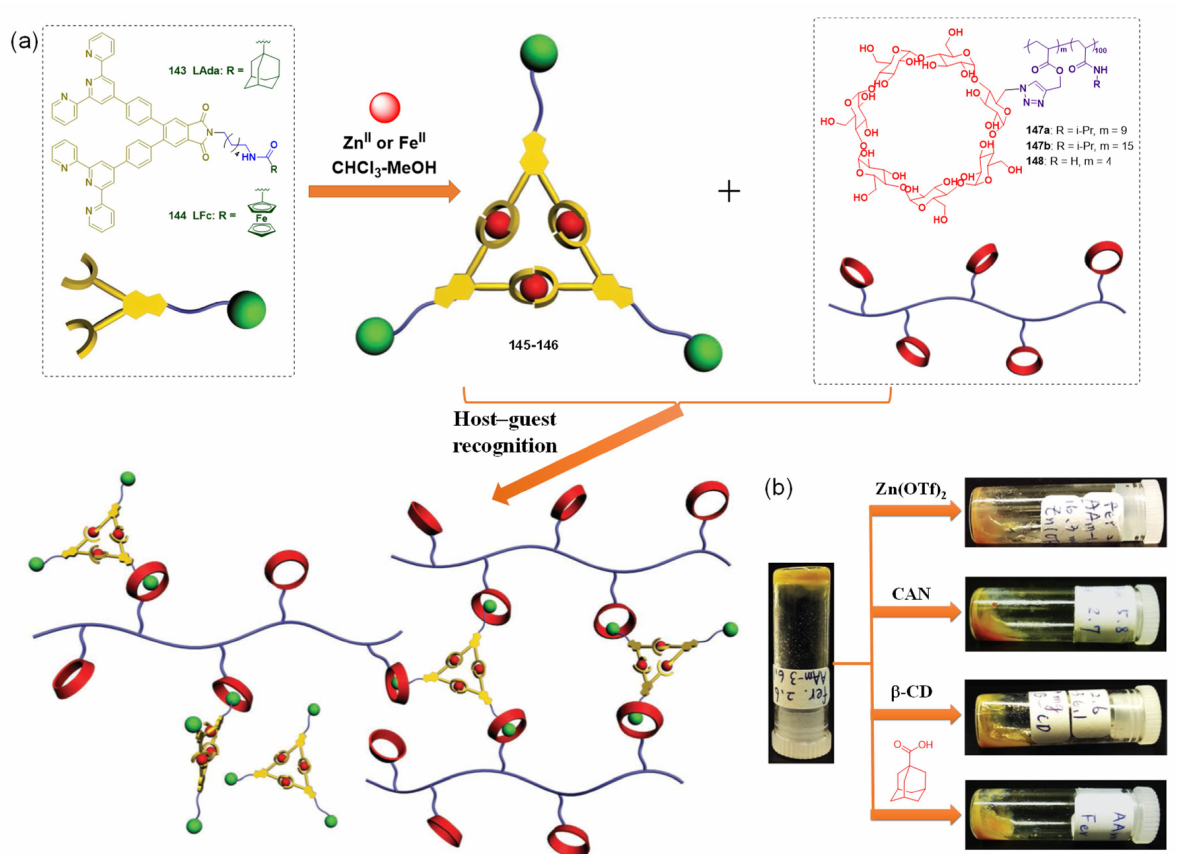
Figure 56. ( a ) Schematic illustration of supramolecular gels constructed through hierarchical self- assembly based on metal–ligand complexation and host–guest recognition. ( b ) Photographs of gel–sol transitions for 145 / 148 triggered by various stimuli. Reprinted with permission from Ref. [139]. Copyright (2018), John Wiley and Sons.